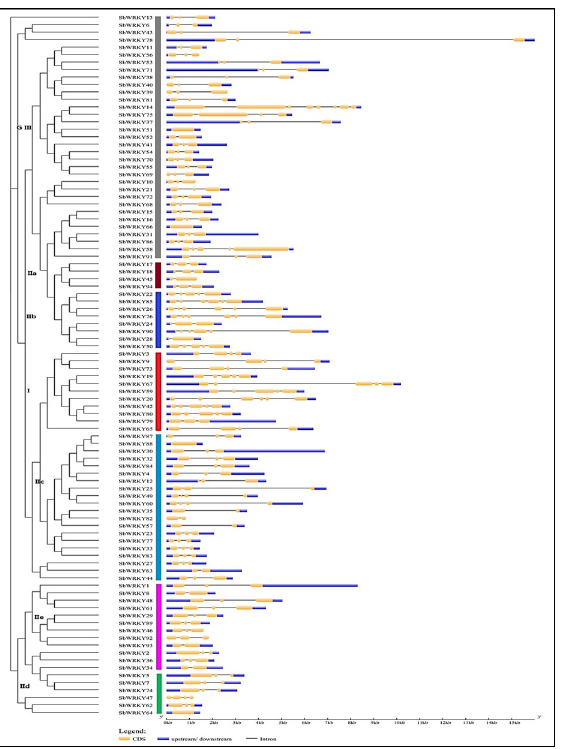
Fig 3. Exon–intron structures of SbWRKY genes. We used the Gene Structure Display Server (GSDS) for gene structure analysis and constructed the phylogenetic tree using MEGA v7.0. In the gene diagrams, blue bars indicate upstream and downstream UTRs, yellow bars indicate coding sequences (CDS), and black lines indicate